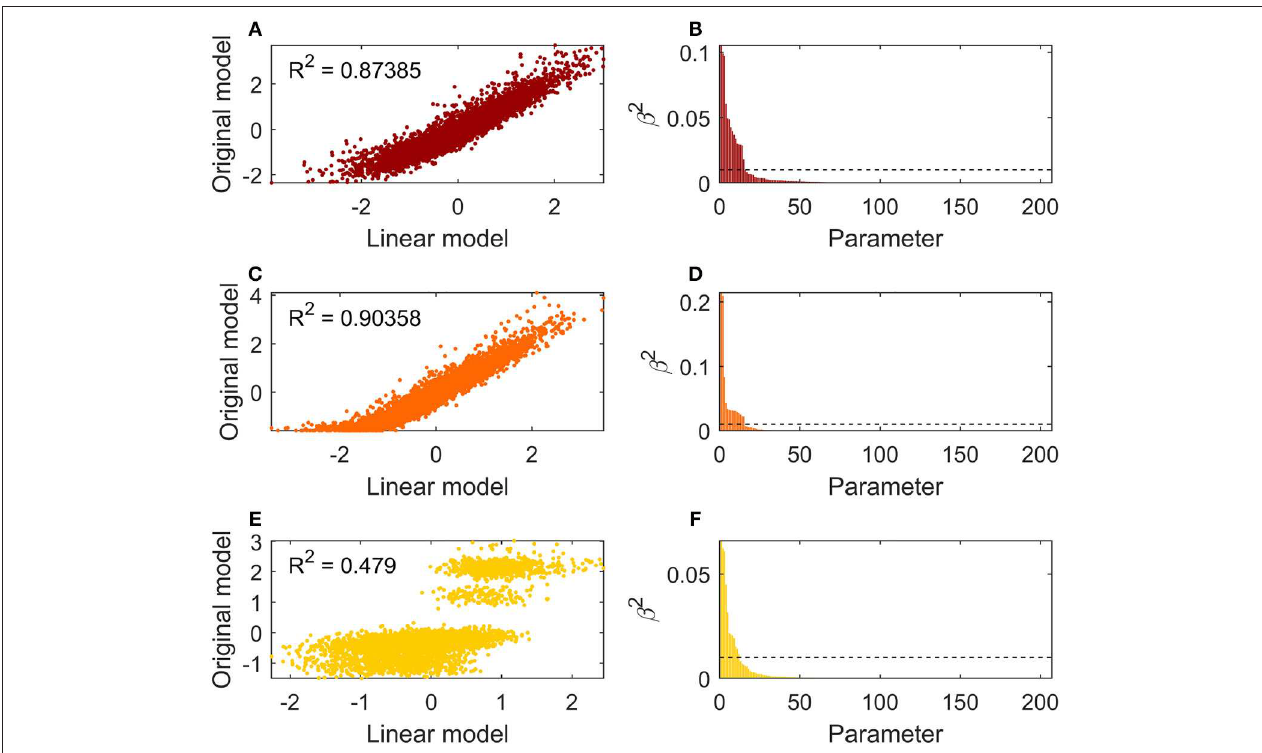
FIGURE 5 | Standardized Regression Coefficients method results of the k = 205 parameters on HU min (A,B) , CU min (C,D) , T pp (E,F) . Figures to the left report the linear model fit to the actual uncertainty. Figures to the right show the β 2 values of the input parameter sorted in descending order. The dotted lines indicate the proposed cut-off